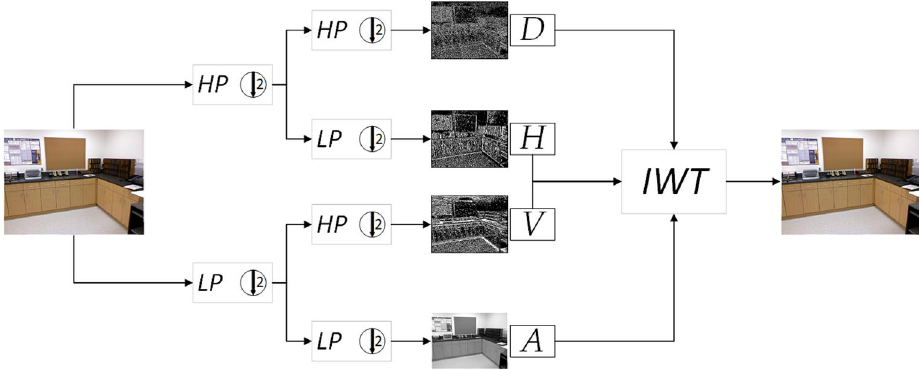
Figure 2. Discrete wavelet transform (DWT) and inverse wavelet inverse transform (IWT).